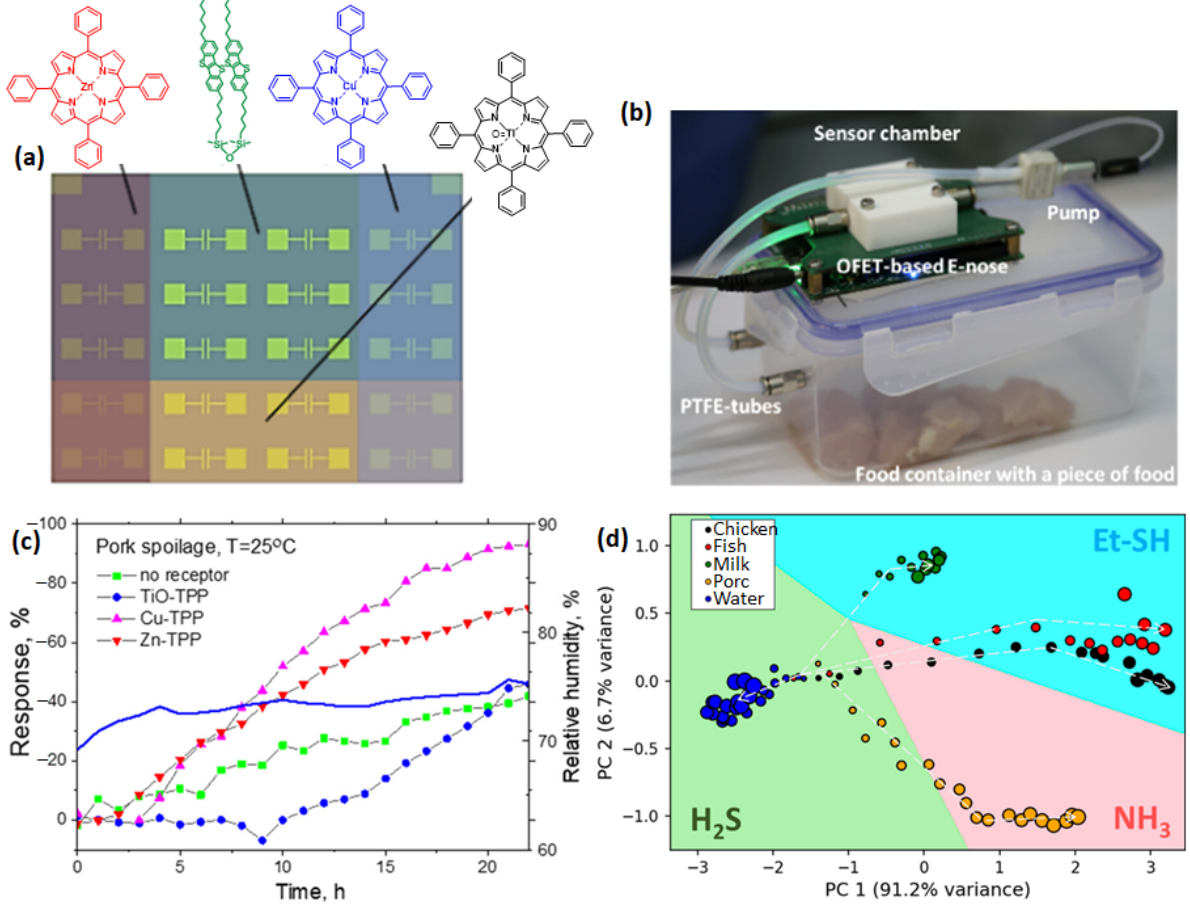
Figure 10. Schematic representation of metal (Zn, Cu, and TiO) porphyrin ‐ based FET sensor arrays ( a ) and a real photograph of an e ‐ nose measurement setup for meat samples ( b ). Comparison of the relative response evolution of different FET sensors towards the aroma collected from a pork sample at different storage times. The variation of relative humidity is indicated in solid blue line ( c ). PCA score plot of the aroma classification of different food products into different biomarkers ( d ). Adapted from ref. [121].